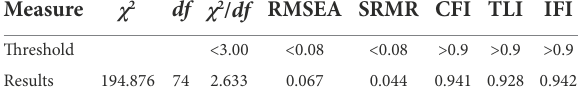
TABLE 9 The test for the main effects.